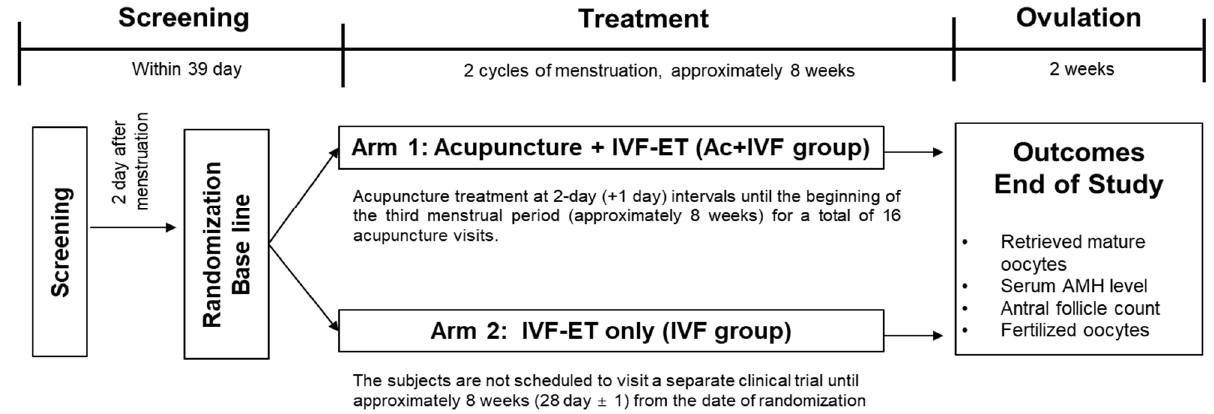
Figure 2. Flowchart of this trial. IVF, in vitro fertilization; AMH, Anti-Müllerian hormone.